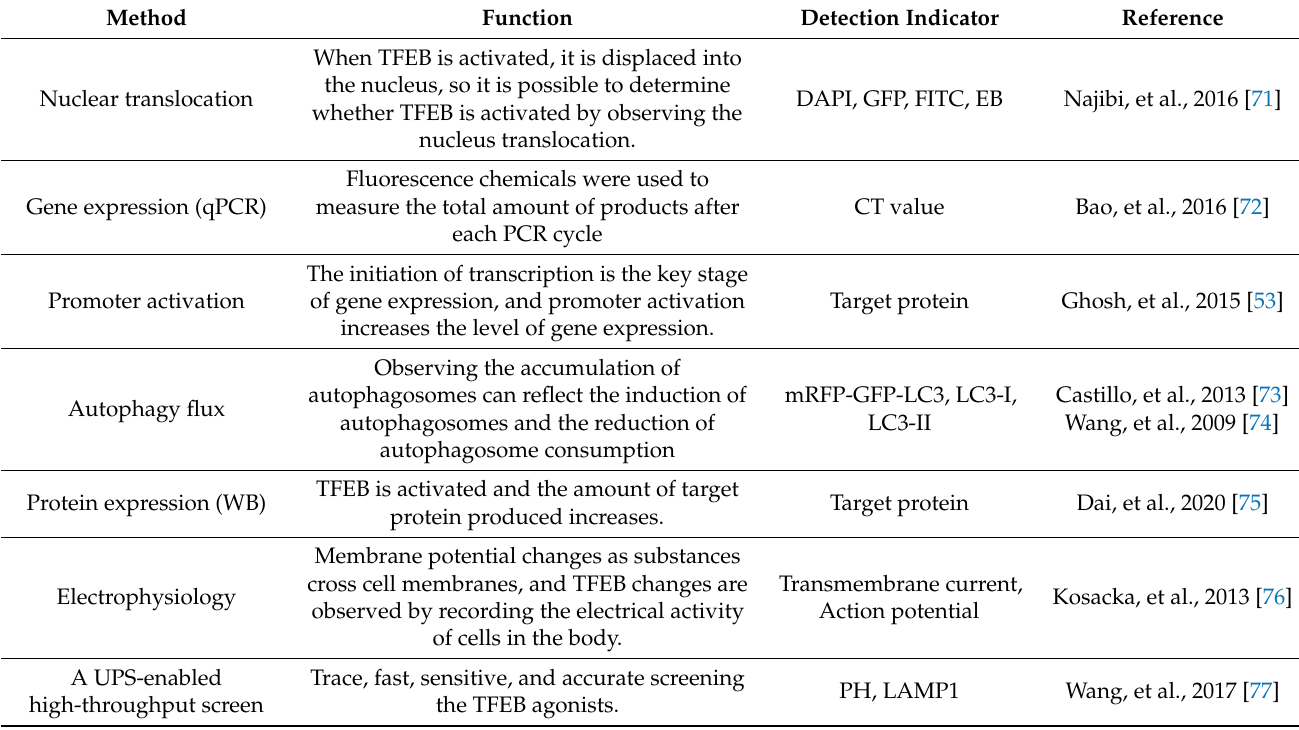
Table 1. Methods to screen TFEB